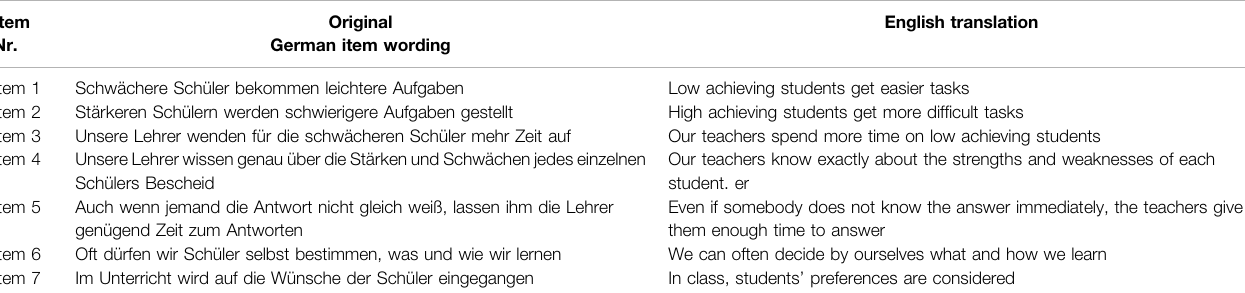
TABLE 2 | English translation of the Differentiated Teaching Scale by Gebhardt et al. (2014). Item Nr.